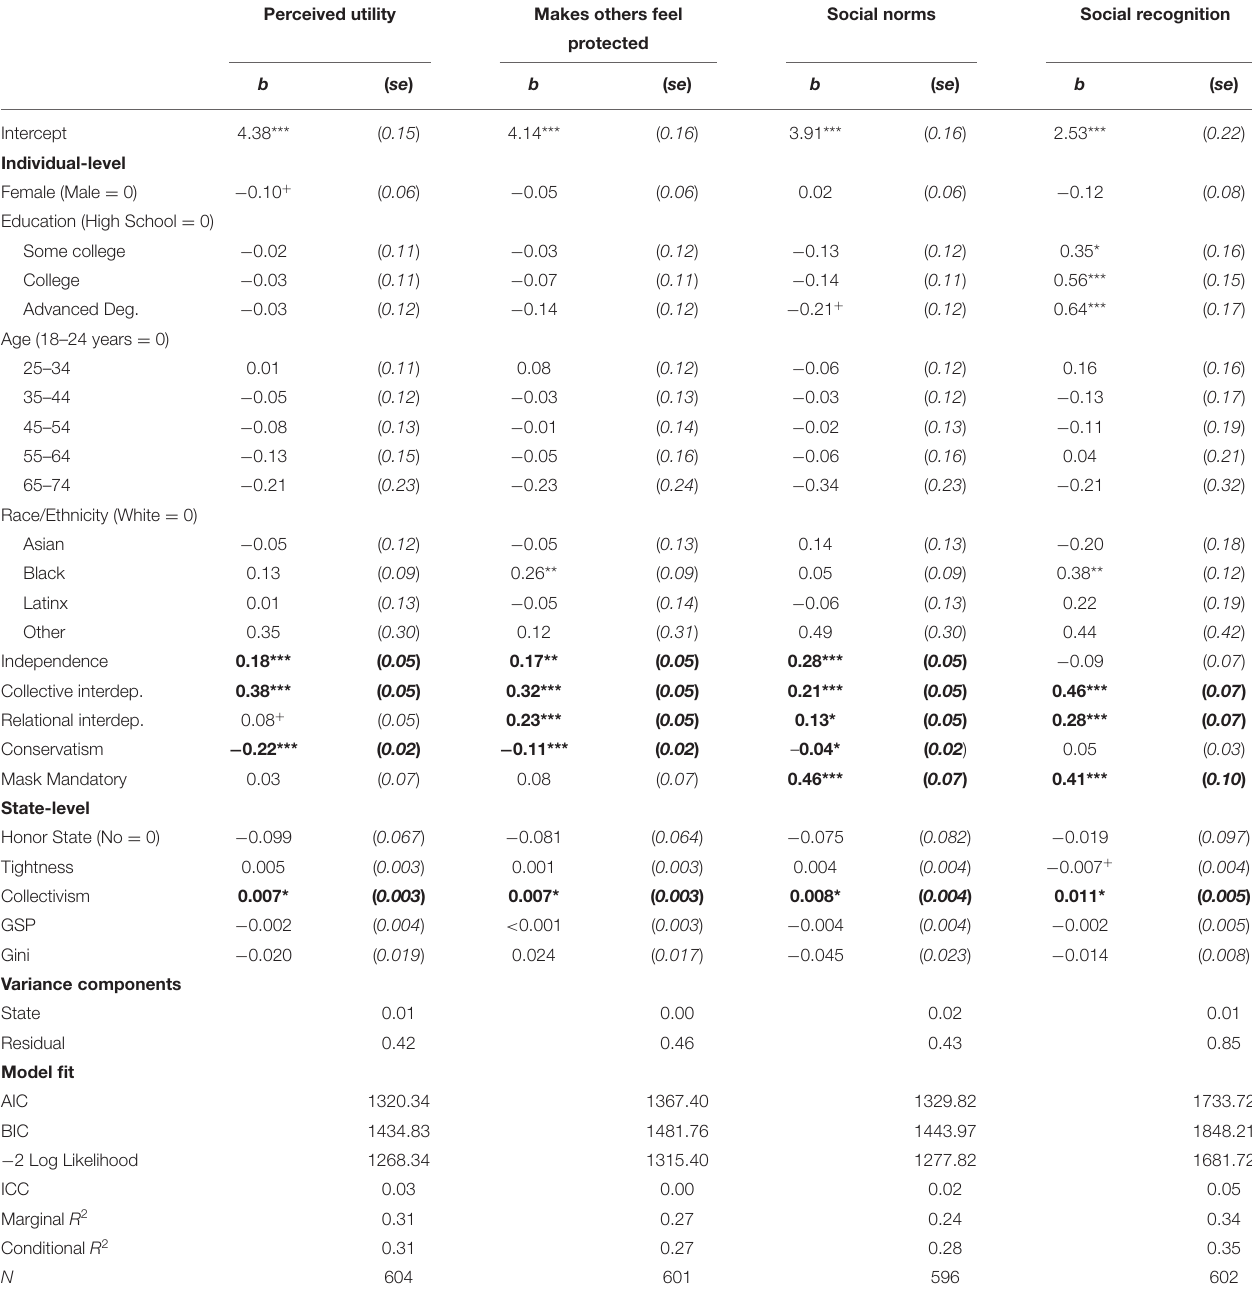
TABLE 4 | Result of multilevel analyses: perceived utility, effects on others, social norms, and recognition. Perceived utility Makes others feel Social norms Social recognition